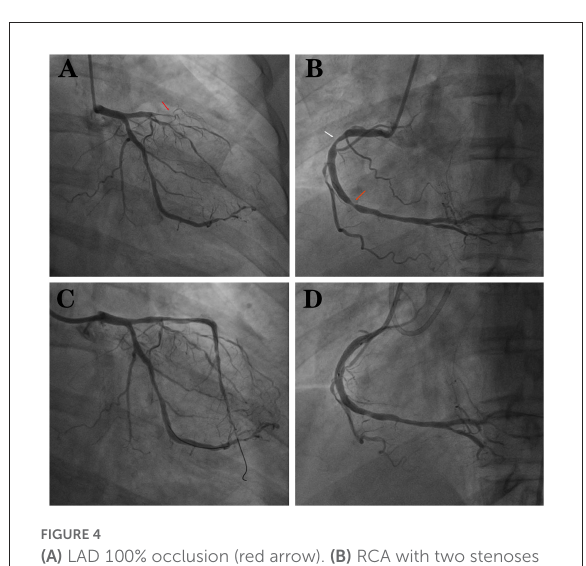
TABLE 1 Timeline of